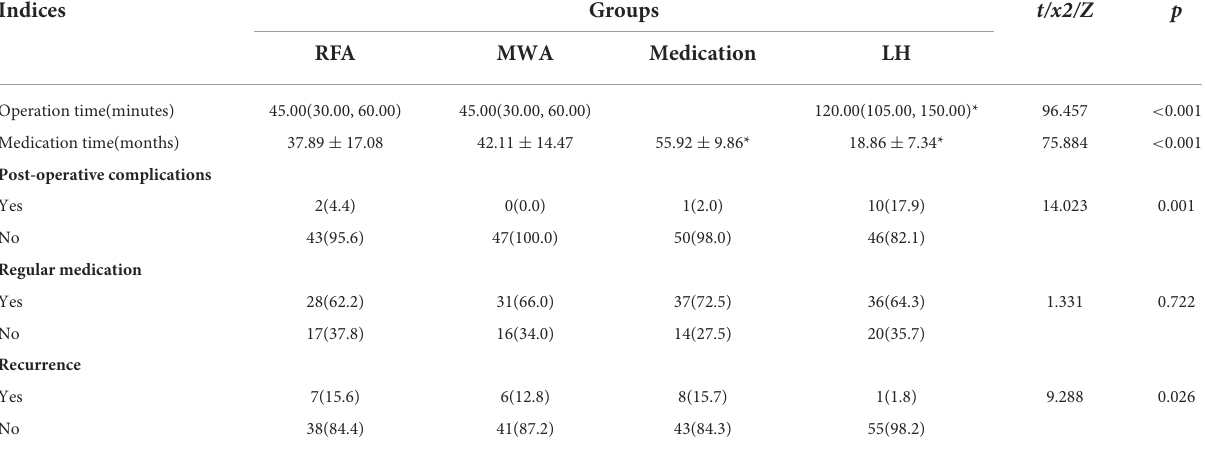
TABLE 2 Comparison of intraoperative and postoperative data of patients with different treatment. Indices Groups